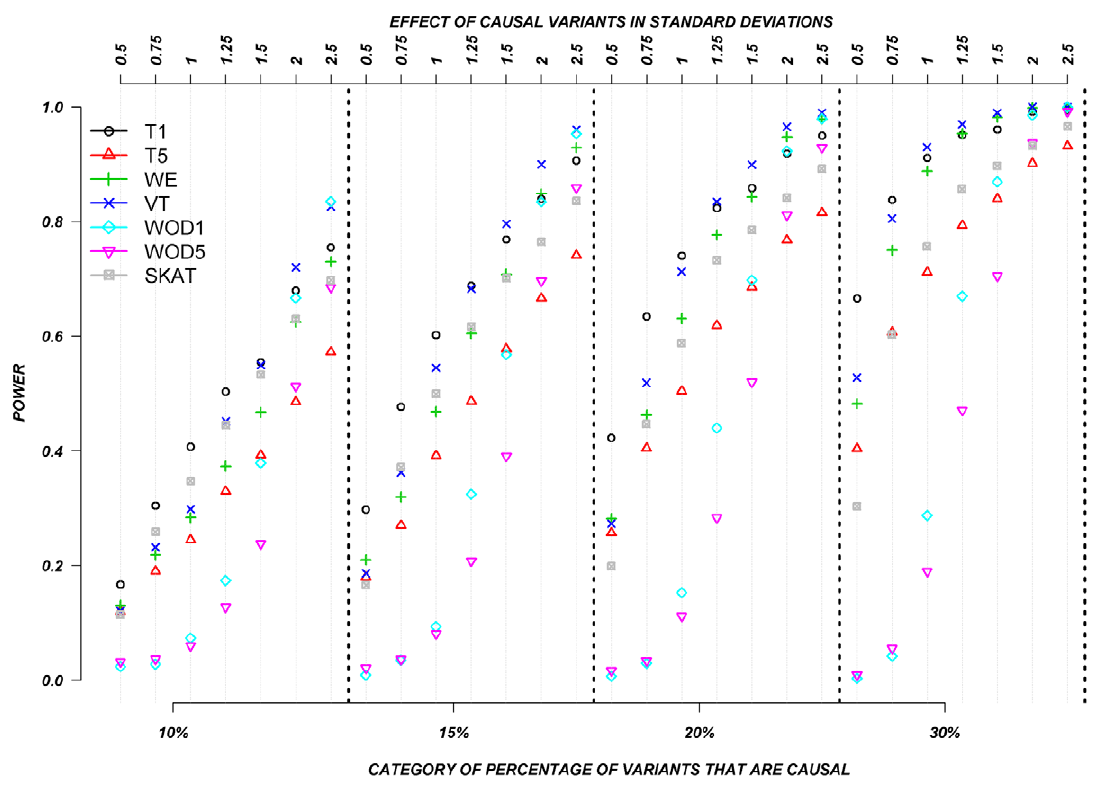
Figure 3. Continuous traits: Relationship between effect size, proportion of causal variants, and power. All causal variants have a deleterious effect. Each box corresponds to a different proportion of causal variants involved in the relationship between rare variants and continuous traits (from left to right, 10, 15, 20 and 30%). On the x-axis, effect sizes are in standard deviations and correspond to the absolute value of the average size effect.